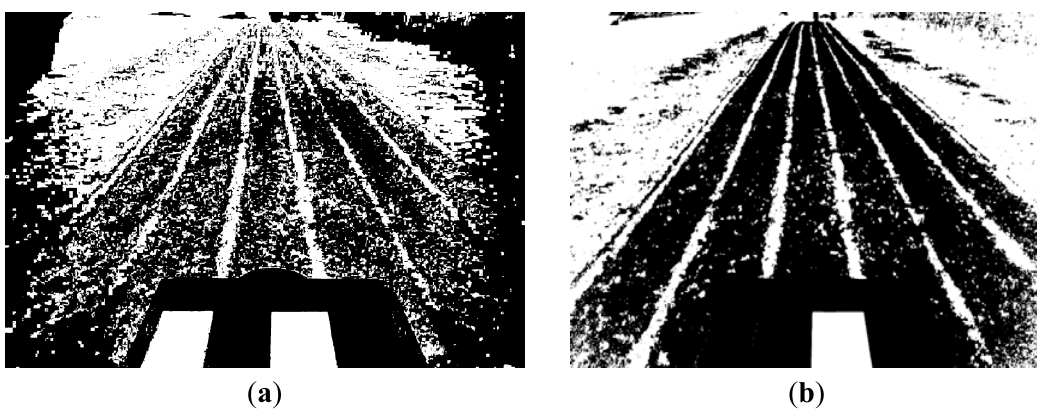
Figure 11. Segmented images obtained from the ones in Figure 4